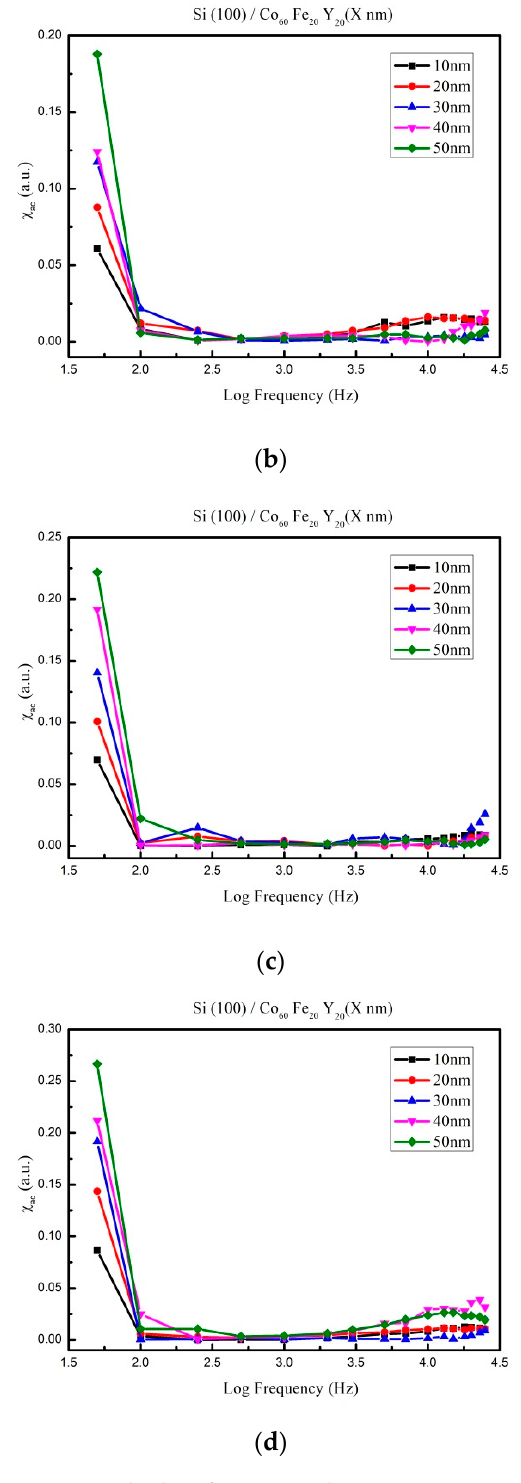
Figure 4. The low-frequency alternate-current magnetic susceptibility ( χ ac ) as a function of the frequency from 50 to 25,000 Hz. ( a ) RT, ( b ) post-annealing at 100 °C, ( c ) post-annealing at 200 °C, and ( d ) post-annealing at 300 °C.